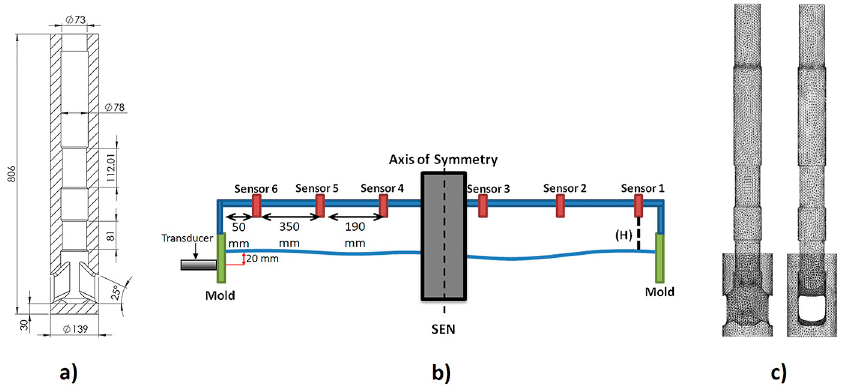
Figure 1. The nozzle and the experimental setup. ( a ) Geometric features of the industrial nozzle (mm). ( b ) The mold model equipped with meniscus levels sensors and the ultrasonic transducer to measure turbulence. ( c ) Interior wall of the nozzle.